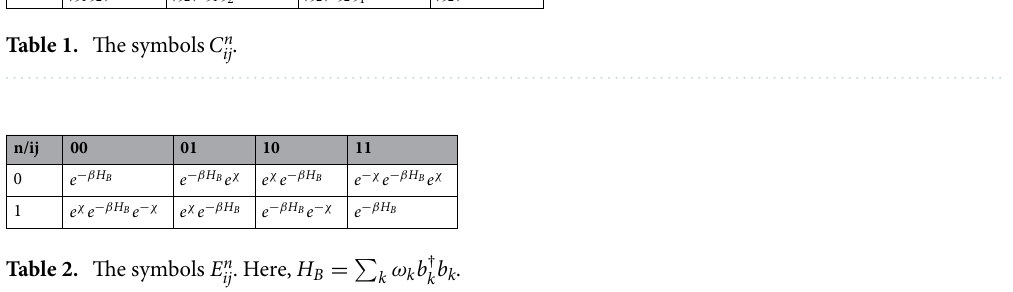
Table 2. The symbols E n ij . Here, H B =